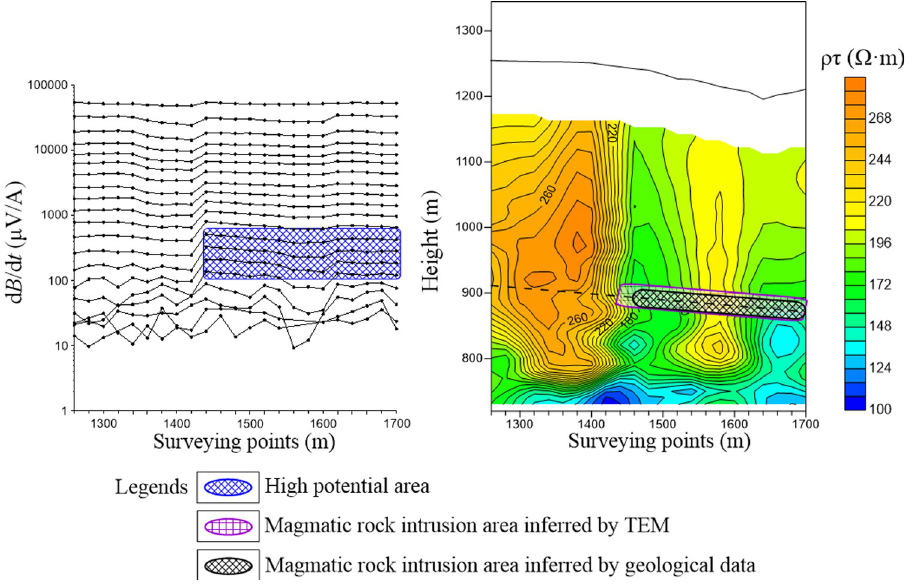
Fig 6. Multi-channel potential profile and apparent resistivity profile of the testing line.